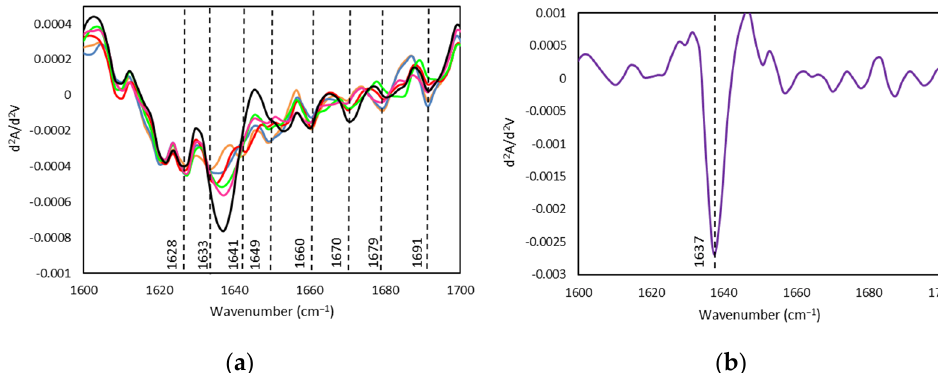
Figure 11. Second Derivative, FTIR spectra of the Ionogels. ( a ) Secondary structure 1600–1700 cm − 1 region of ( — ) GE, ( — ) GE/1IL, ( — ) GE/5IL, ( — ) GE/10IL, ( — ) GE/15IL,( — ) GE/25IL and ( b ) ( — ) IL. Table 6. Assignments of IR bands to the secondary structure of GE and Ionogels.